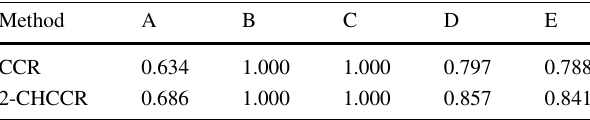
Table 6 Comparison of efficiency scores between CCR and 2-CHCCR models ( 𝜃 = 10 )